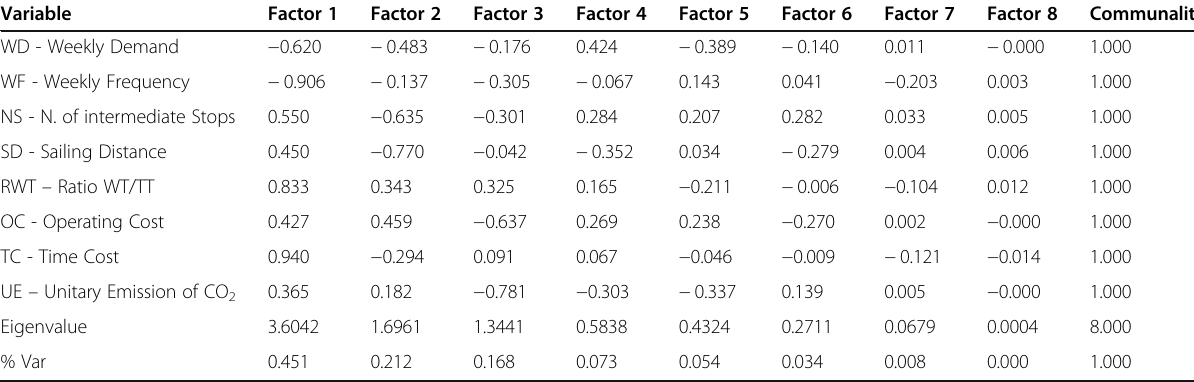
Table 11 Unrotated factor loadings and communalities – Optimized network